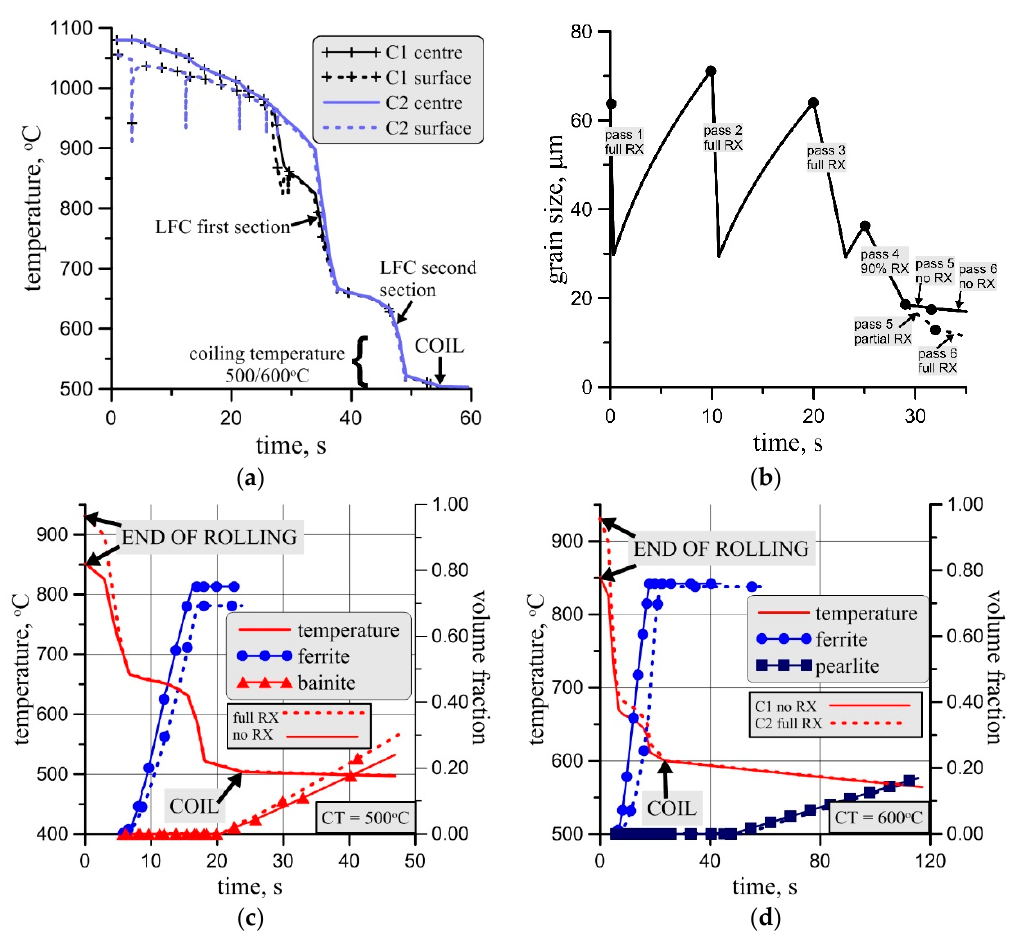
Figure 15. Time temperature profiles ( a ) and grain size changes ( b ) for cases 1 and 2, and kinetics of the transformations for the cooling temperature 500 °C ( c ) and 600 °C ( d ).